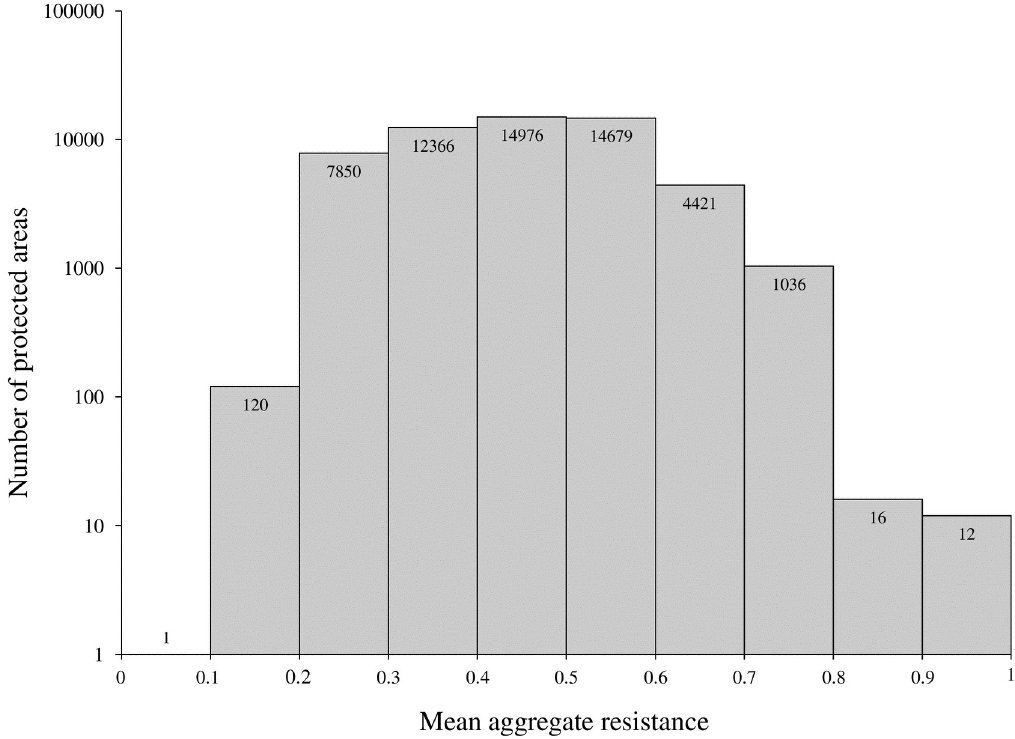
Fig 5. Aggregate focal species resistance within New England’s protected areas. Mean aggregate resistance provides a standardized indicator of resistance for each protected parcel based on the average focal species resistance within the parcel. Graph displays trends in mean aggregate resistance within individual